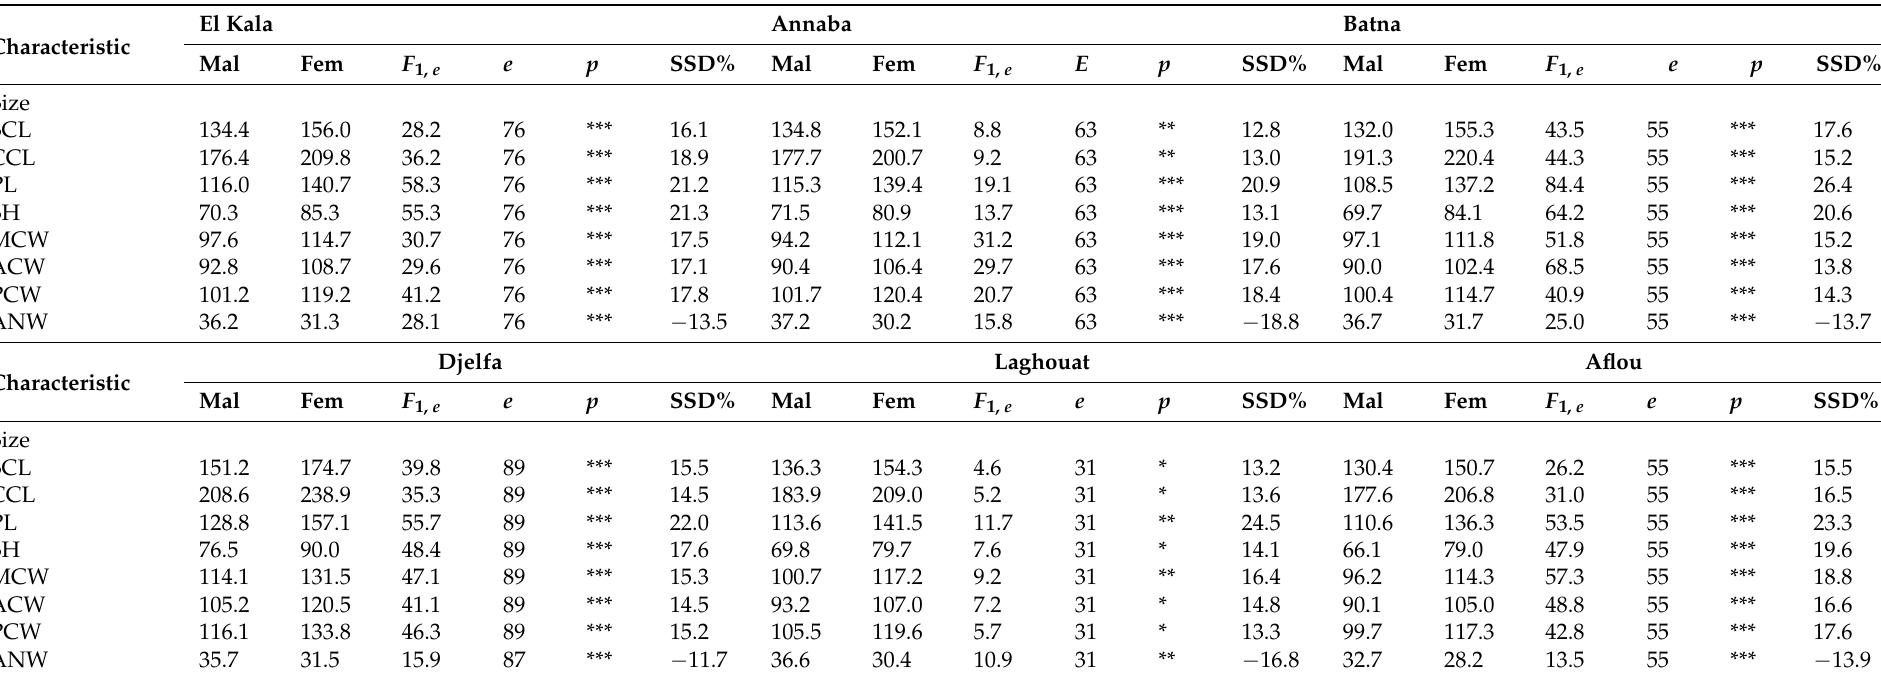
Table A1. Sexual dimorphism of body size among adults of Algerian T. graeca populations. Abbreviated characteristics are explained in the Materials and Methods section. Here, the results for size are taken as means expressed in millimeters. Mal—males; Fem—females. F and p values for body size are from a one-way